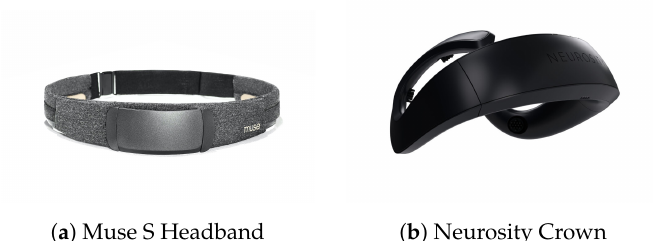
Figure 2. Two consumer-grade EEG devices with integrated electrodes used in the